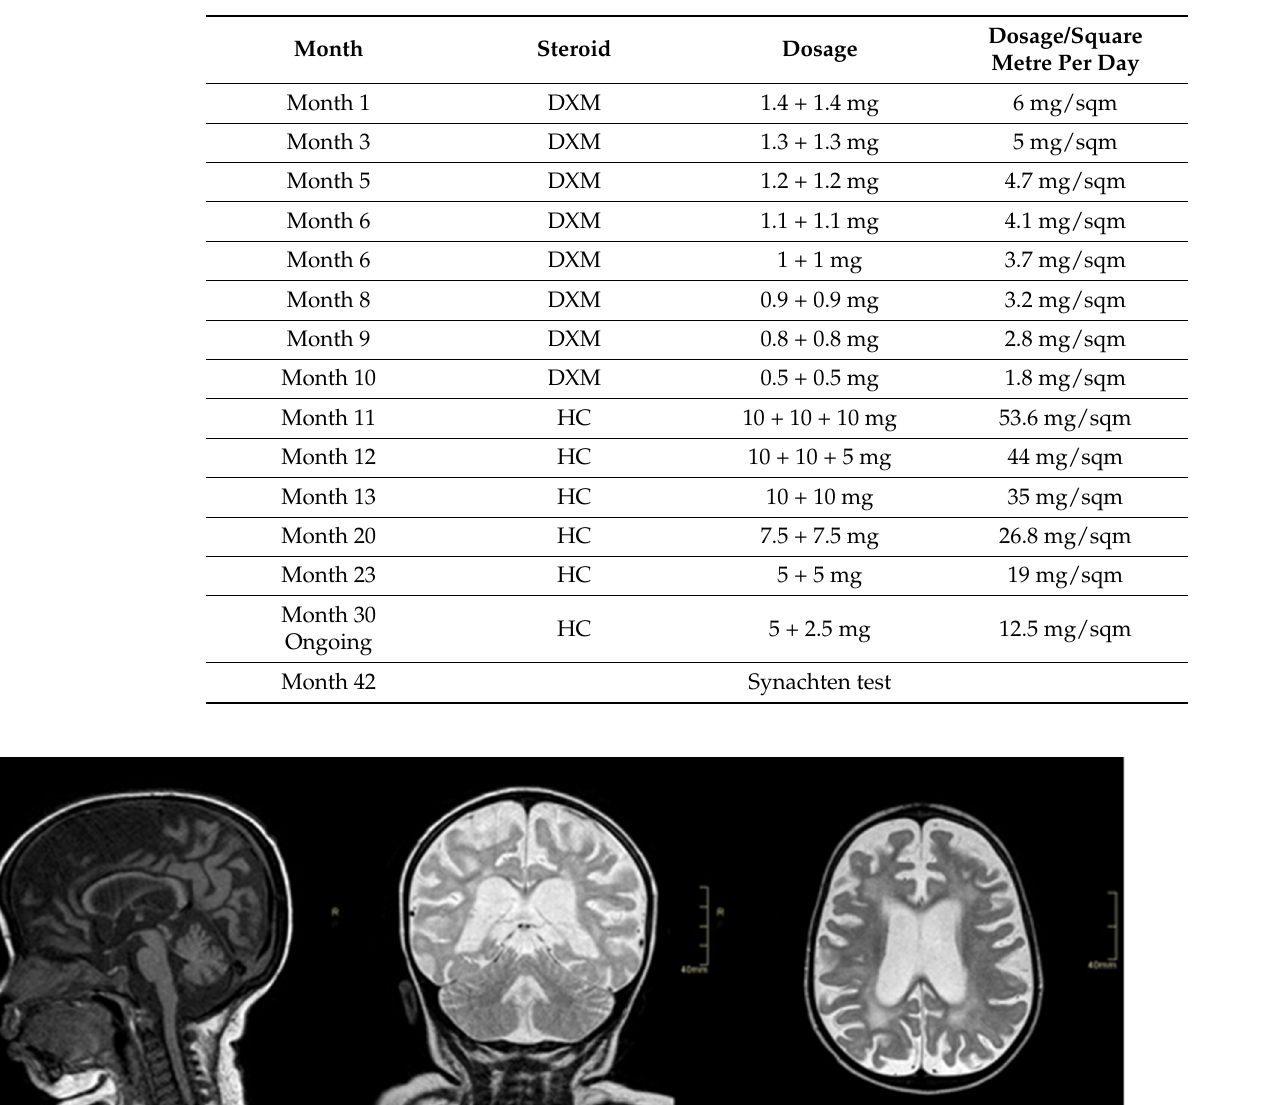
Table 1. Progressive tapering of steroid therapy: DXM—dexamethasone; HC—hydrocortisone.